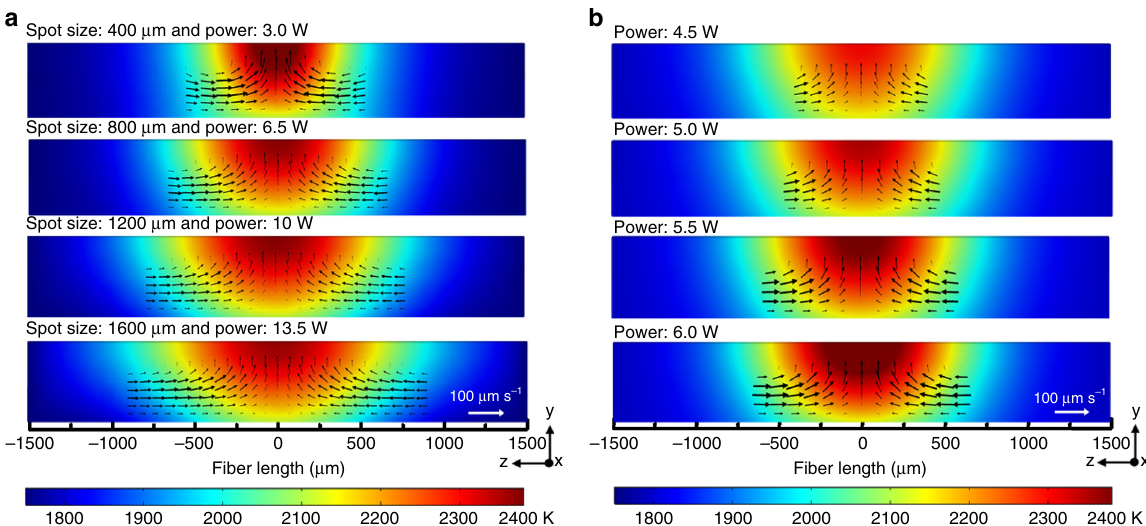
Fig. 3 Simulation results of the laser induce in- fi bre temperature gradient and fl ow velocity pro fi les of the thermocapillary convection which drags the particles up. a Analysis of the in fl uence on the in- fi bre temperature distribution and fl ow velocity pro fi les according to laser spot sizes. The laser spot size increases from 400 to 1600 μ m with suf fi cient laser power from 3 W to 13.5 W, resulting in an increase of the thermocapillary fl ow radius. The soften length of fi bre cladding also increases from 600 to 1800 μ m. b Analysis of the in- fi bre temperature distribution and fl ow velocity pro fi les according to different laser powers. The laser power increases from 4.5 to 6 W with a laser spot size of 400 μ m, resulting in an increase of the fl ow velocity from 5 to 80 μ m s − 1 . In a and b , the total fi bre length is 3 mm and fi bre diameter is 550 μ m; The laser is focused at the centre of the top